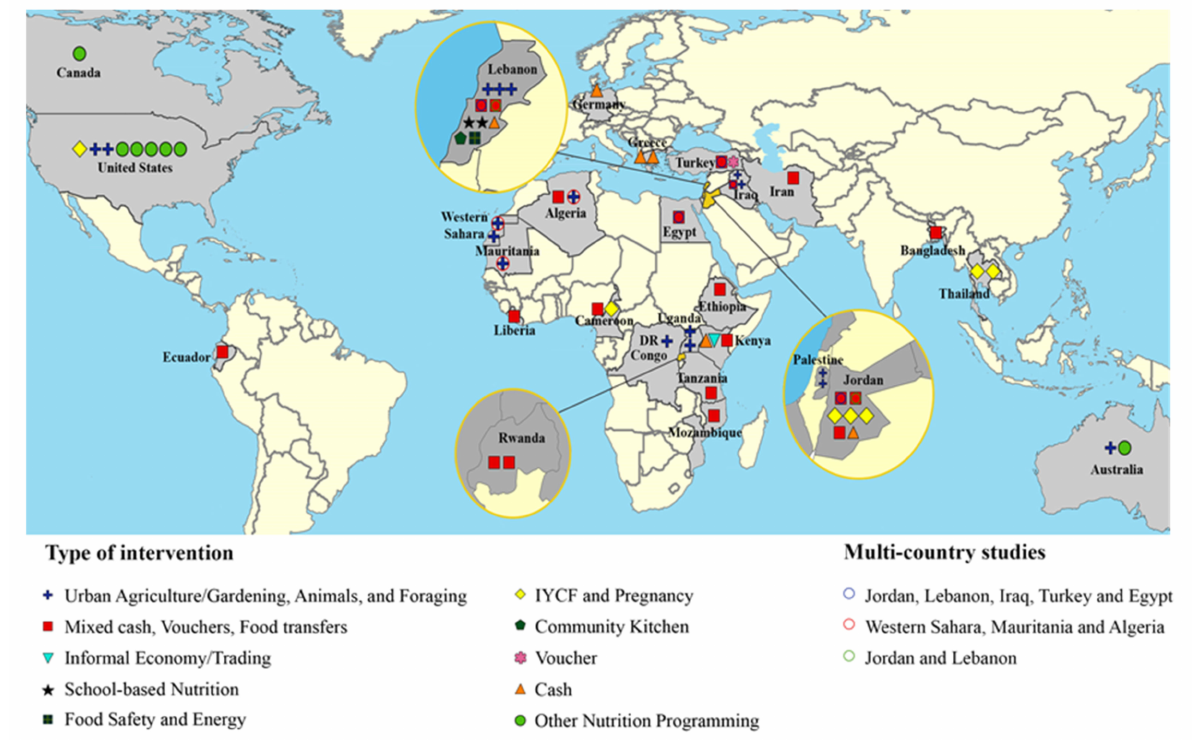
Figure 4. Intervention types according to